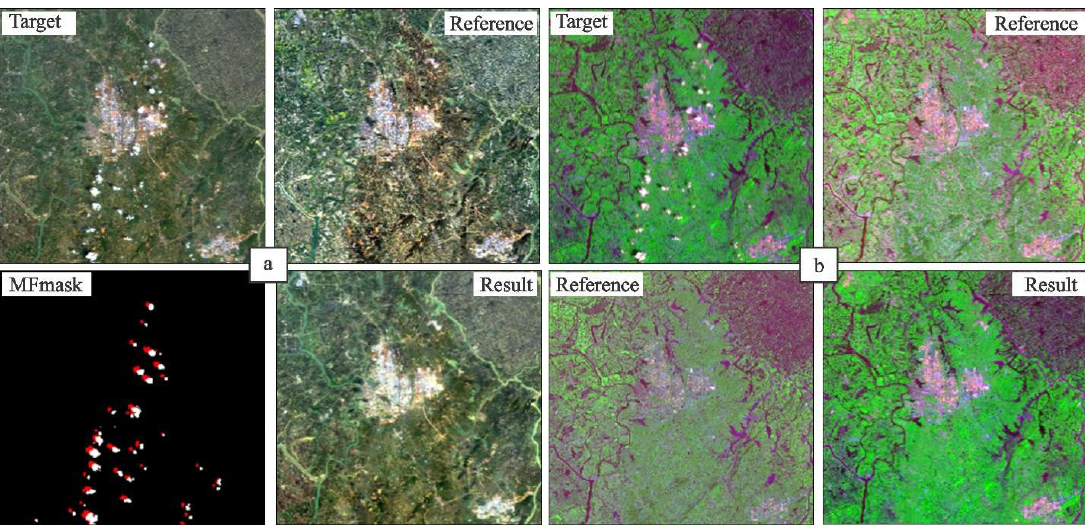
Figure 10. LRM results from Landsat8 OLI image (p120r38_20160429) for site E in Figure 7a located in Southeast China near Nanjing City (1000 × 1000 pixel subset), ( a ) (bands 4, 3 and 2 composited) and ( b ) (bands 5, 4 and 3 composited). Upper left shows a subset of Landsat8 OLI images with cloud and cloud shadow cover. Upper right shows the corresponding subset of the reference OLI image (p120r38_20160328). Lower right shows the corresponding reconstructed results by the proposed LRM algorithm. ( a ) (bands 4, 3 and 2 composited), Lower left represents the MFmask results containing clouds (white), cloud shadows (red) and clear sky (black). ( b ) (bands 5, 4 and 3 composited), lower left shows the corresponding subset of the reference OLI image (p120r38_20160312).